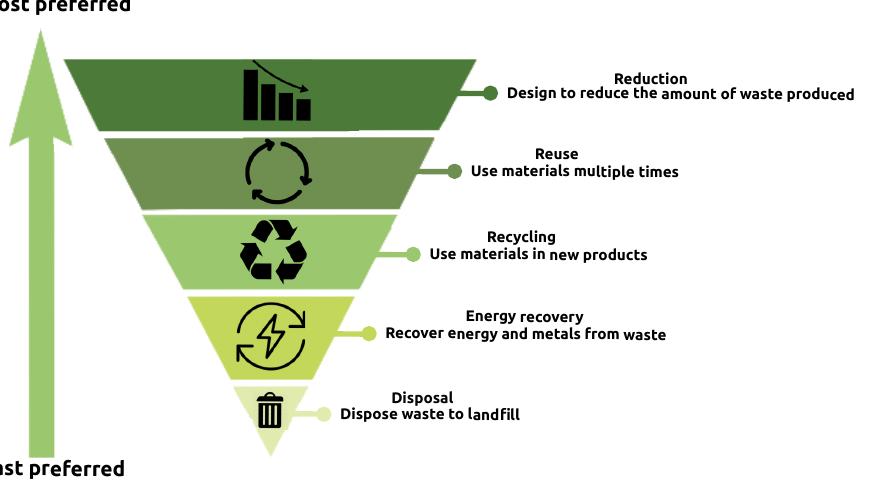
Figure 1. Waste Management Hierarchy.